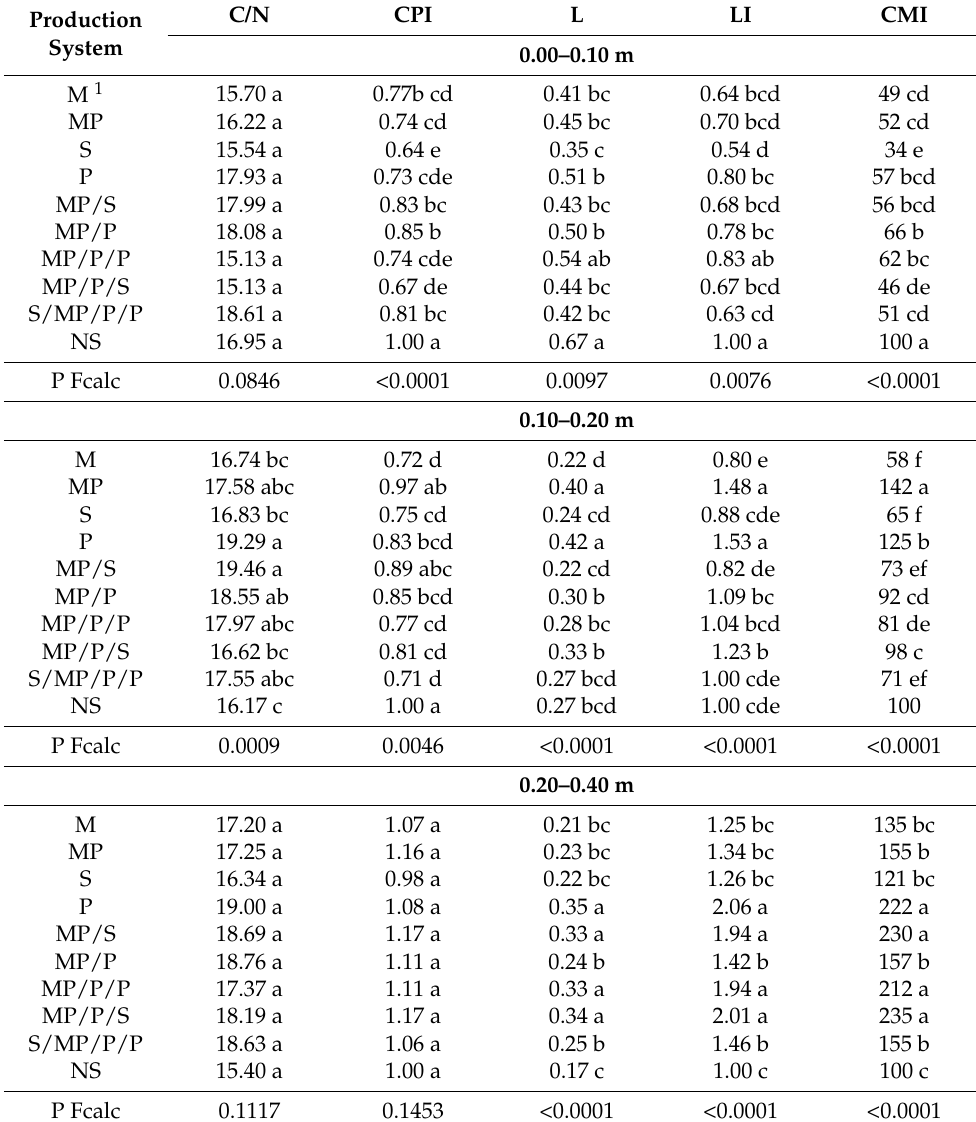
Table 4. Soil C/N Ratio, Carbon Pool Index (CPI), Lability (L), Lability Index (LI) and